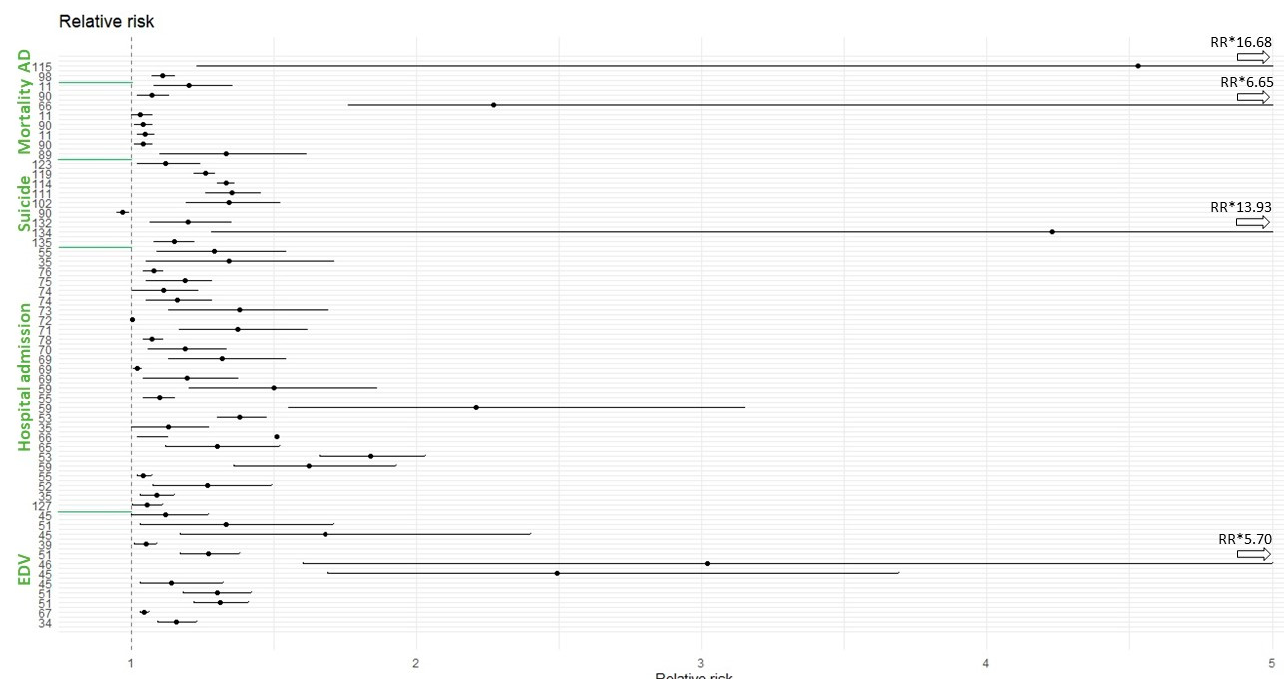
Figure 4. Forest plot of significant results (relative risk), divided by type of demanded service. The numbers on the y -axis represent the study references. Abbreviations: AD: ambulance dispatch; EDV: emergency department visit. RR * represents the respective RR upper limits.